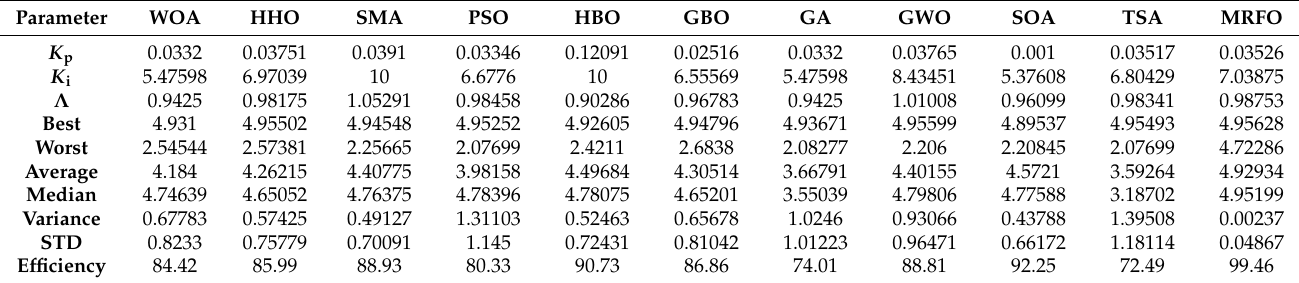
Table 1. Optimal parameters of optimized fractional MPPTS and statistical evaluation (30 runs).